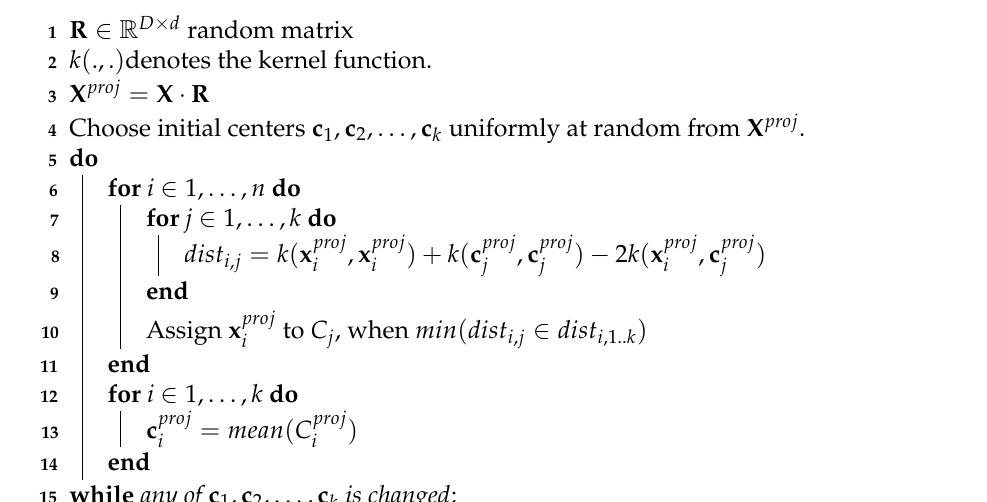
Algorithm 1: Kernel k-means with random